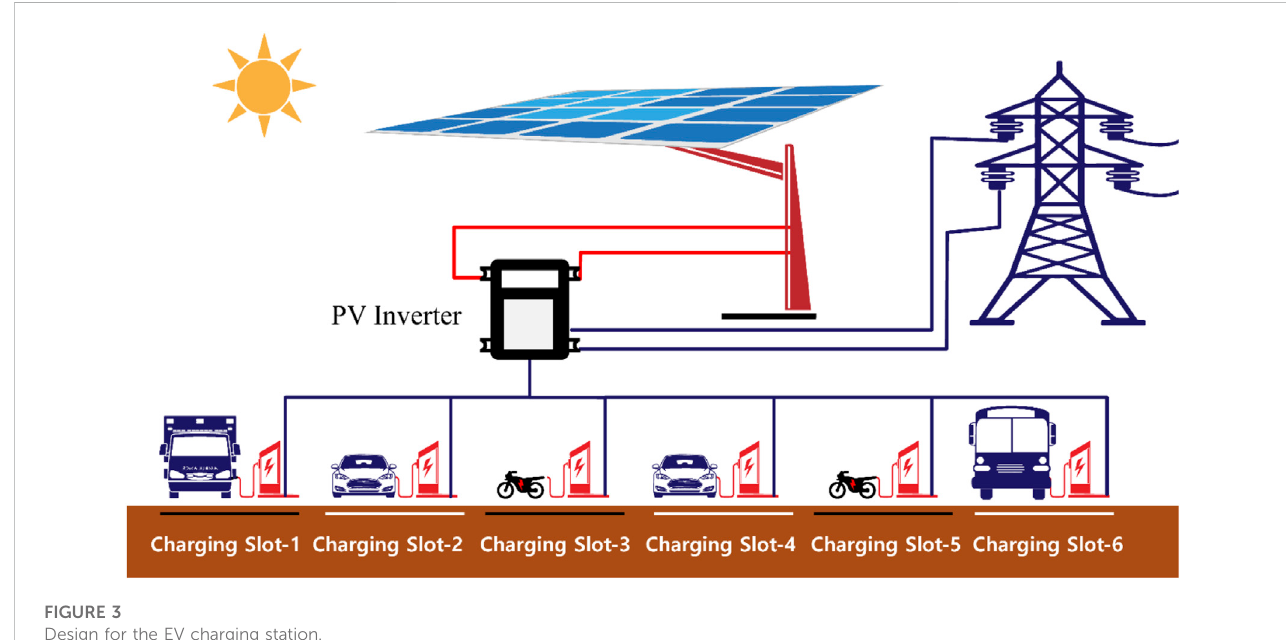
FIGURE 3 Design for the EV charging station.